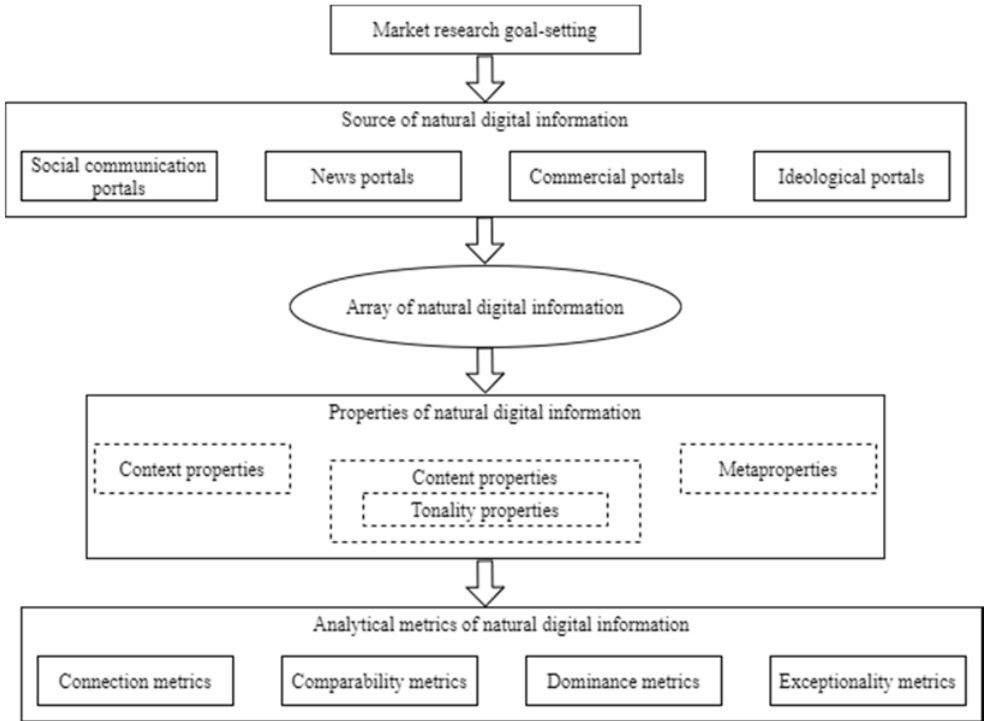
Figure 2. Algorithmic model for analyzing natural digital information in the context of market re- search.